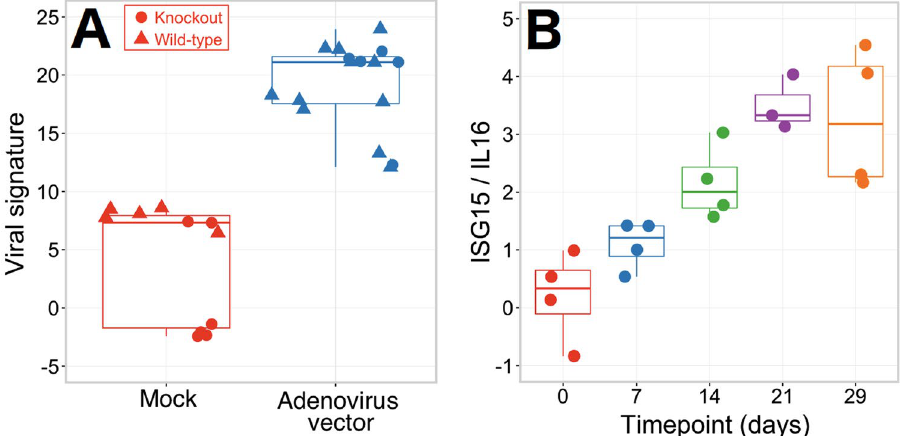
Figure 1. Pan-viral signature in models of infection involving DNA viruses. Panel (A): Adenovirus (double- stranded DNA; Baltimore group I). Pan-viral signature measured in liver tissue derived from wild-type or C3-knockout mice injected with phosphate buffered saline (mock) or adenovirus type 5 capsids (vector), from dataset GSE4128. The box and whisker plots show the median and interquartile range for each group. The pan- viral signature produced AUC = 1.00. Panel (B): Porcine circovirus (single-stranded DNA; Baltimore group II). Dataset GSE14790 was generated from samples of peripheral blood, drawn weekly from four Landrace CDCD piglets infected with subclinical doses of PCV2 (Burgos isolate) at day 7 post-gestational age and followed for 29 days. The OASL gene was not available on the microarray, so only the ISG15/IL16 component of the pan-viral signature is shown here, in a box-and-whisker plot of median and interquartile range for four individual piglets at different days post-inoculation. The ISG15/IL16 component of the pan-viral signature produced AUC = 0.94 for day 7 vs. day 0 comparison, and AUC = 1.00 for days 7, 14, 21, 29 vs. day 0 comparison.